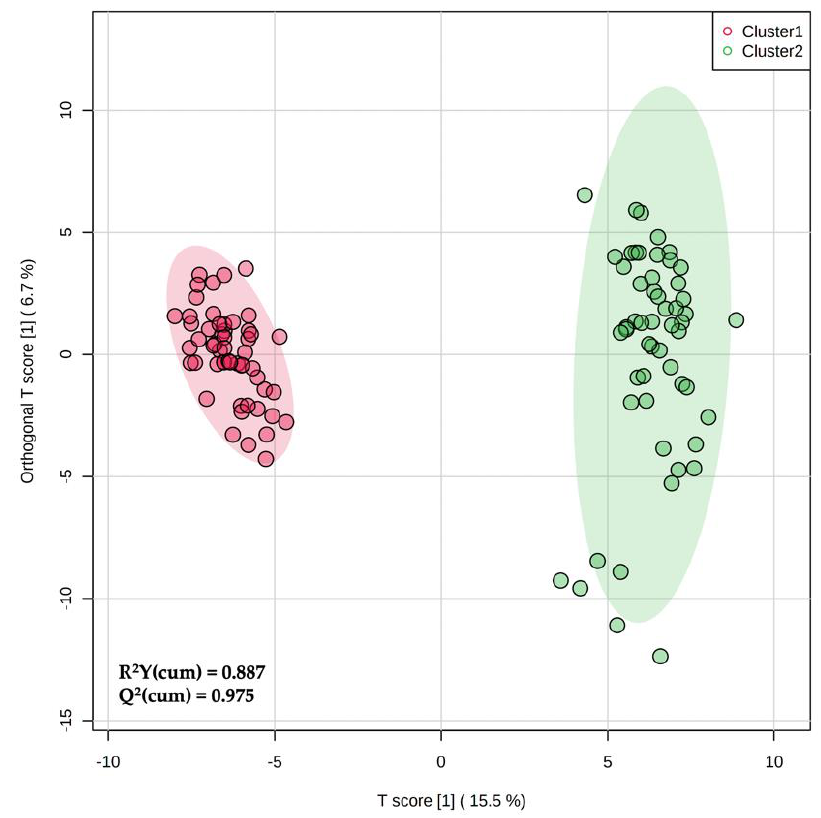
Figure 2. Orthogonal projection to latent structures discriminant analysis (OPLS-DA) score plot when considering the two phenolic groups (Cluster 1 and Cluster 2) outlined by unsupervised clustering analysis.